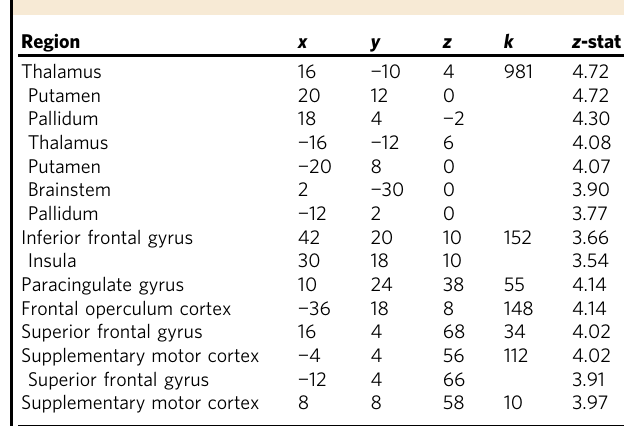
Table 1 fMRI activity for high versus low targets